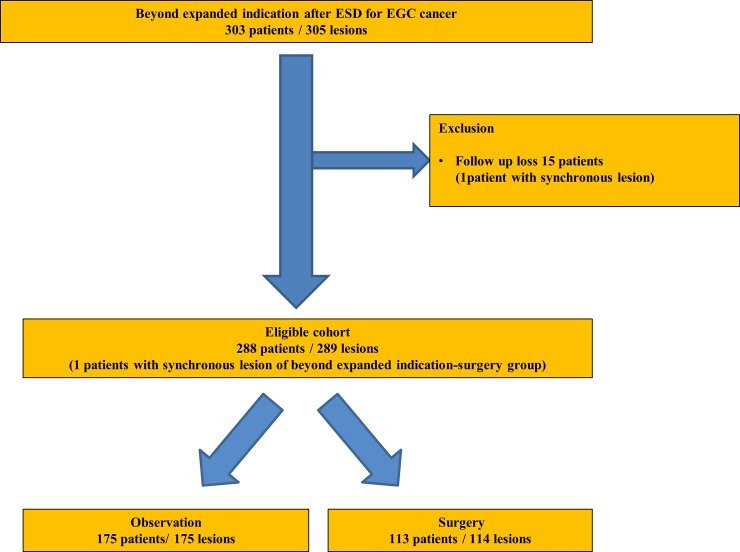
Study flow diagram.ESD, endoscopic submucosal dissection; EGC, early gastric cancer.